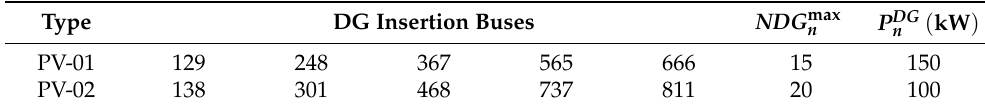
Table 3. Case study II: insertion buses, maximum number of DG modules and unity capacity. Type